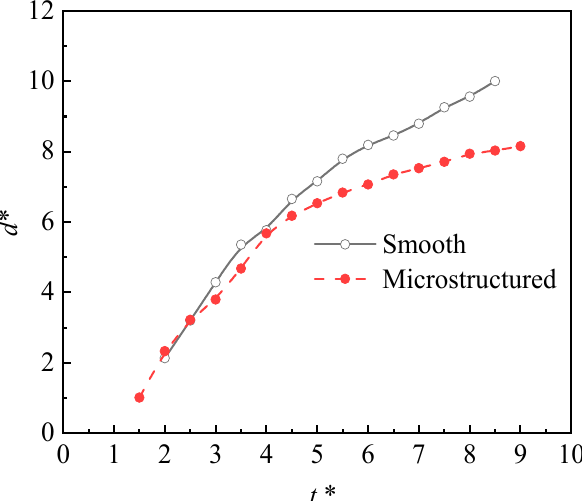
Figure 12. Comparison of spreading diameter between smooth surface and micro-structured surface.